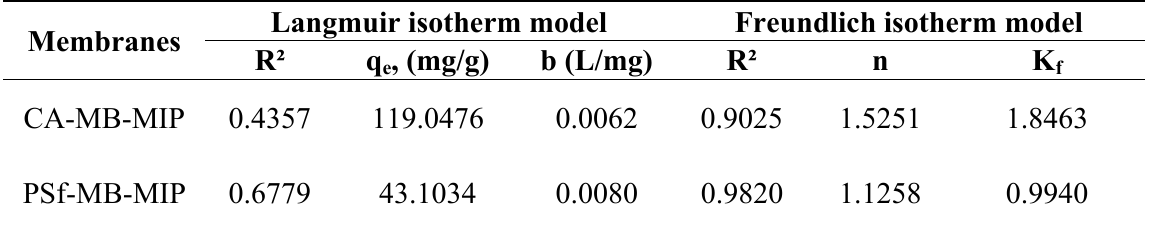
Table 2. Langmuir and Freundlich constants for the sorption of MB dye solution.